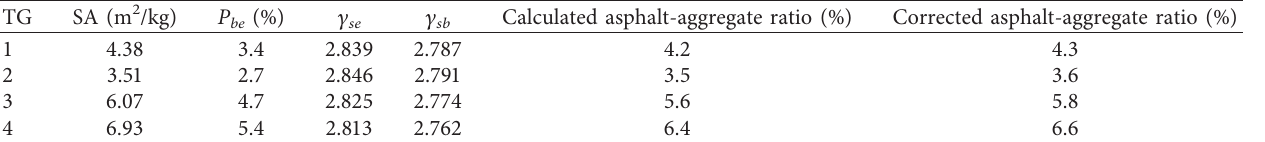
Table 8: Determination of asphalt-aggregate ratios of TGs 1–4.